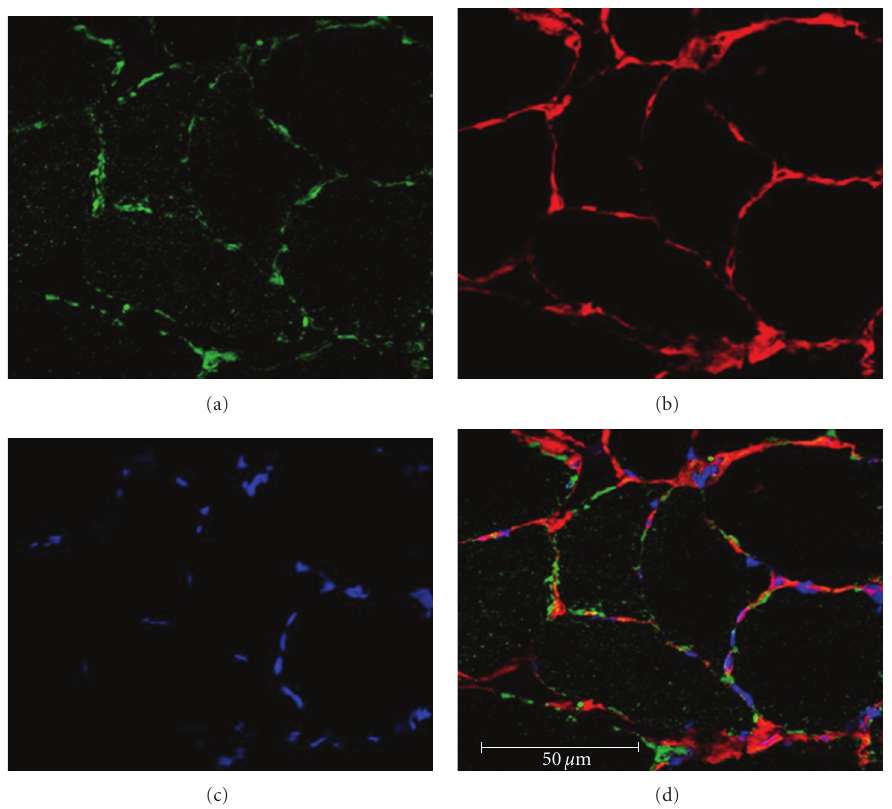
Figure 1: Staining of neutral lipid droplets (LDs) with BODIPY (493/503) in cross section of rat soleus muscle demonstrates staining within the fiber, but especially under the surrounding sarcolemma. (a) Fibers stained with BODIPY (green) demonstrate the appearance of spherical LDs within the muscle fibers as previously described with Oil Red O staining procedures. (b) To provide anatomical localization, the membrane is labeled with wheat germ agglutinin (WGA)-Alexa Fluor 594 (red). (c) Nuclei were stained with DAPI (Blue). (d) Merged triple label image of the muscle section. All images were taken at 63x, and a scale bar is provided for reference.